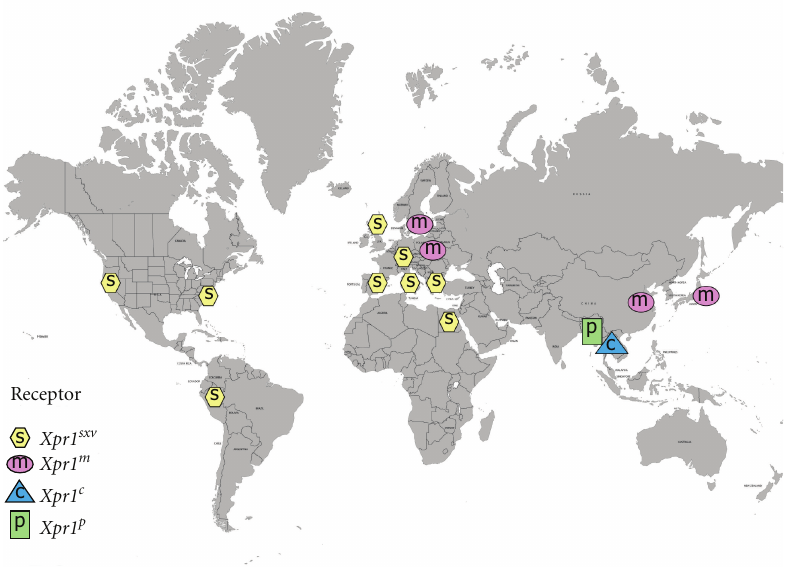
Figure 7: Geographic distribution of Xpr1 alleles in wild mouse populations.